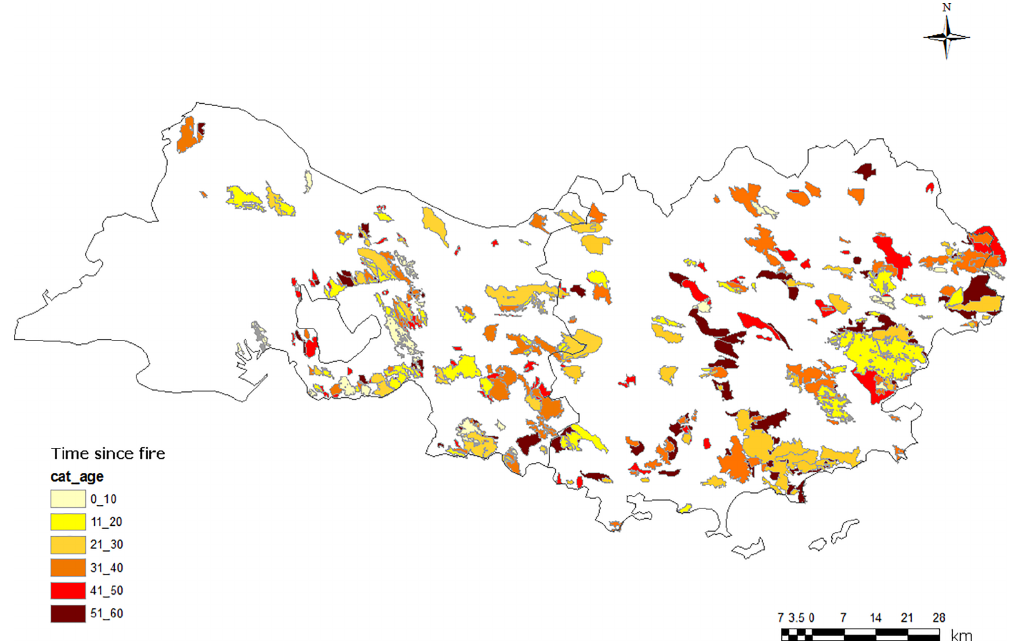
Figure 2. Time since the last LF (cat_age in